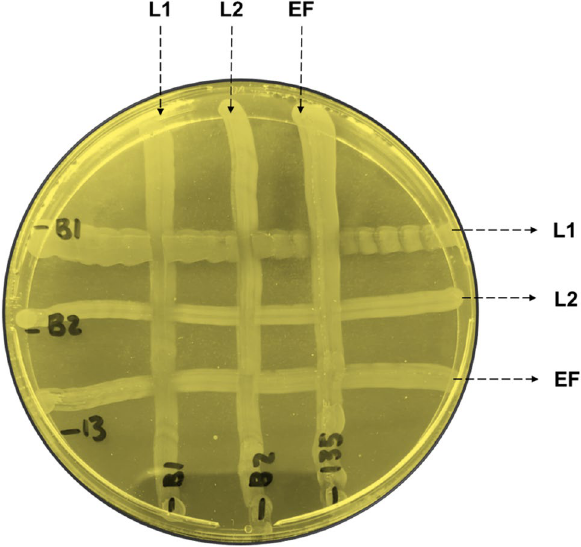
Figure 3. Coexistence test between isolates L. lactis (L1 and L2) and E. faecium (EF). No antagonist effects were observed.